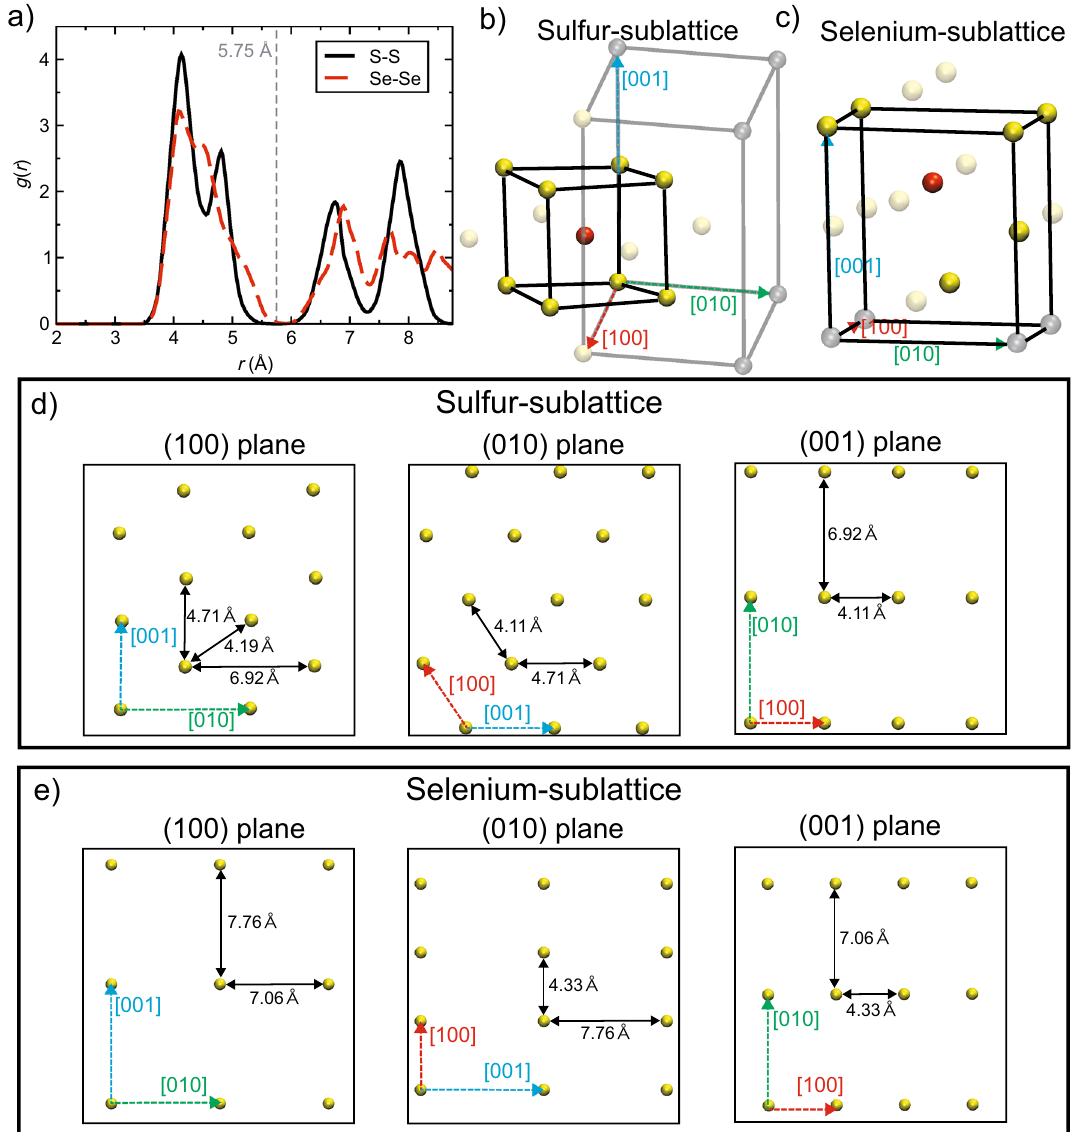
Figure 6. Structural identification of the anion-sublattice in Ag 2 S and Ag 2 Se. ( a ) pair distribution function g SS ( r ) and g SeSe ( r ) (red dashed curve) at ambient condition. ( b and c ) local geometry around an atom in ( b ) sulfur- and ( c ) selenium-sublattice. The red, yellow and gray balls show the centering, neighbor, and the other atoms, respectively. The black and gray solid lines show unit cell of the anion-sublattices and m-Ag 2 S crystal, respectively, where the unit cell of m-Ag 2 Se crystal is congruent with that of selenium-sublattice. The transparent balls are out of the unit cell. ( d and e ) Atomic arrangement and average interatomic distances on the (100) (left), (010) (middle), and (001) (right) plane in ( d ) sulfur- and ( e ) selenium-sublattice. The red, green, and blue dashed arrows in b to e show [100], [010], and [001] direction,